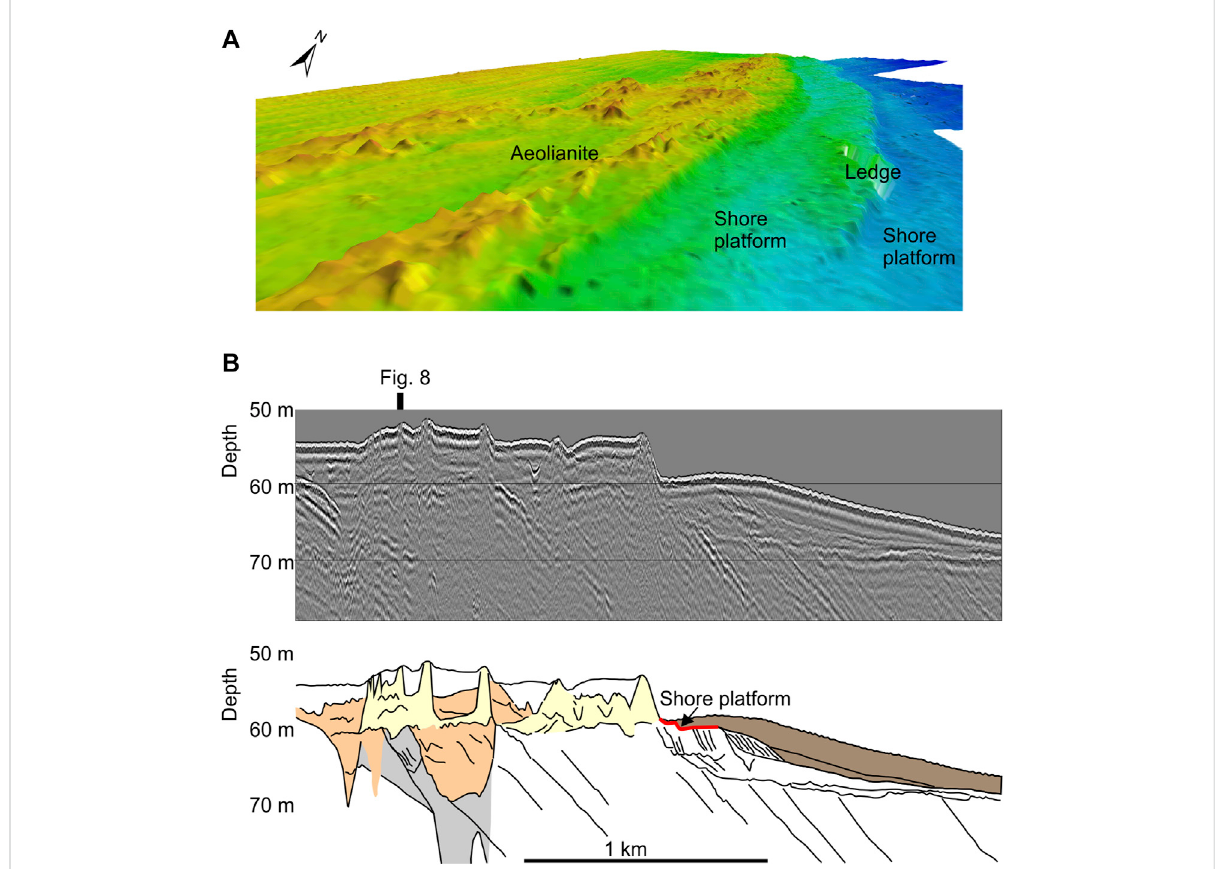
FIGURE 11 (A) 3D multibeam representation of the seabed offshore uMhlanga/uMdloti. Note the landward aeolianite with two shore platforms benched into the rock surface, denoting a rocky shoreline occupation at 60 m (B) . Interpreted (top) and uninterpreted (bottom) seismic re fl ection pro fi les through the above aeolianite. Note the underlying incised valley, the back barrier system to landward of the aeolianite, and the bench to seaward of the aeolianite, into the fringing material at 60